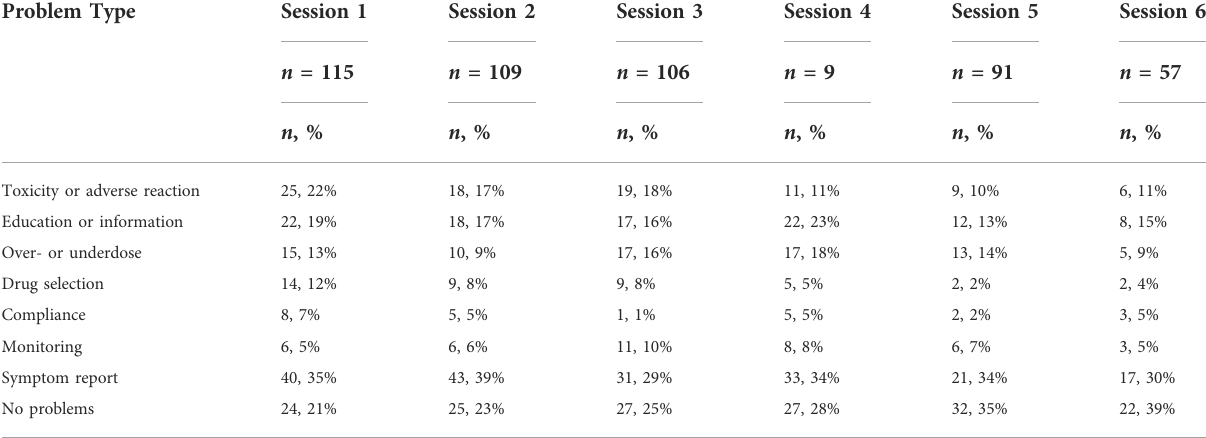
TABLE 2 Number of residents identi fi ed with medicine-related problems, by session and by problem type. Problem